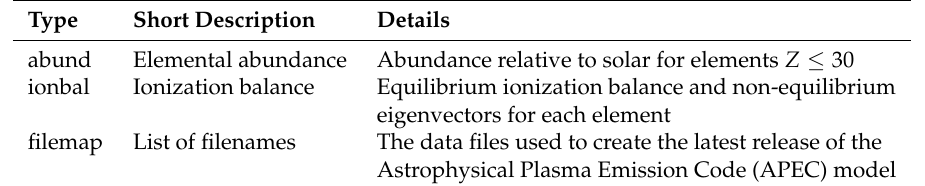
Table 2. File types for global atomic data in APED. A full description of the data files and formats is included in Appendix